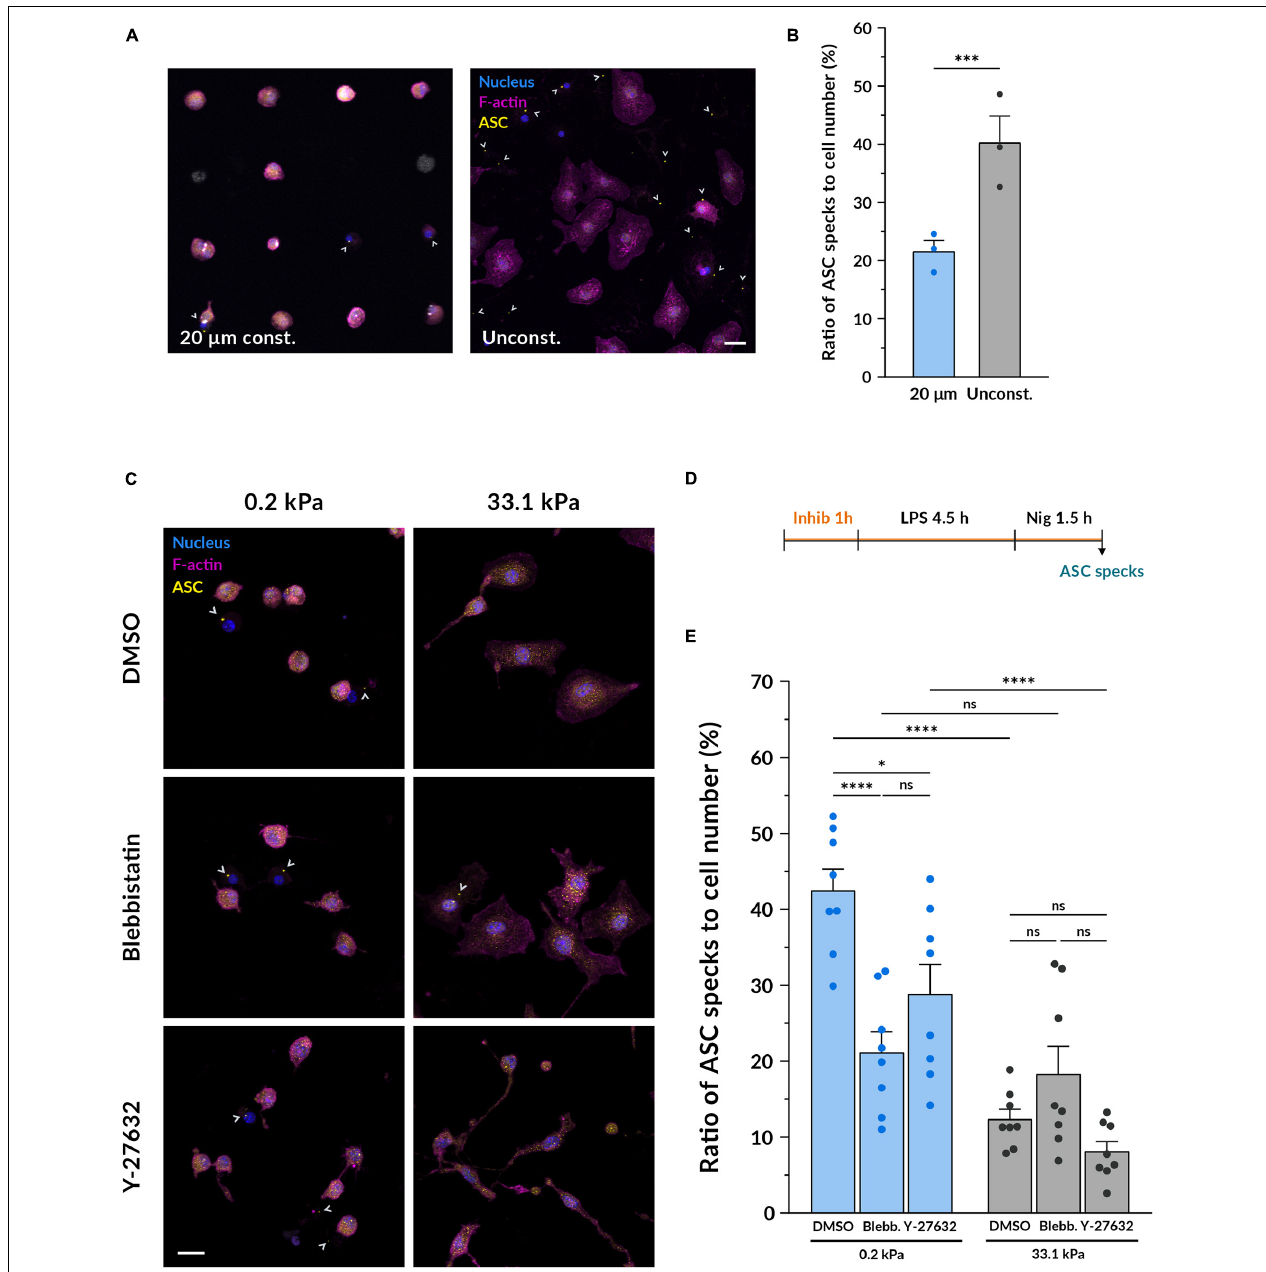
FIGURE 4 | Inhibiting myosin but not limiting cell spreading diminishes the differences induced by stiffness on inflammasome formation. (A) Representative confocal microscopy images of inflammasome formation under cell confinement. BMDMs were cultured on fibronectin-coated circular islands micropatterned on a glass substrate with a diameter of 20 µ m. Unconfined cells were grown on fibronectin-coated glass coverslips growing in an unconfined manner. After 14–18 h of culture, they were primed with 100 ng/ml LPS for 4.5 h and stimulated with 10 µ M nigericin for 1.5 h. Nuclei shown in blue, F-actin in magenta and ASC in yellow. Scale bar, 20 µ m. (B) Quantification of the ratio of ASC specks to cell number. Mean ± SEM are shown and each dot indicates an independent experiment done with BMDMs from different mice. The total number of cells analyzed was 1560 for the 20 µ m confined and 1524 for the unconfined adhesion area. Statistical analysis was performed using a 1D linear mixed model and p -values were determined by a likelihood ratio test. ∗∗∗∗ p < 0.0001. (C) Representative confocal microscopy images of inflammasome formation under actomyosin inhibition. BMDMs cultured on hydrogels for 14–18 h were pretreated with either 1:1700 DMSO as a control, 10 µ M blebbistatin or 10 µ M Y-27632 for 1 h. Keeping the respective inhibitor molecules, cells were then primed with 100 ng/ml LPS for 4.5 h and stimulated with 10 µ M nigericin for 1.5 h. Nuclei shown in blue, F-actin in magenta and ASC in yellow. Scale bar, 20 µ m. (D) Scheme of the experimental treatment applied in (C,E). (E) Quantification of the ratio of ASC specks to cell number. Mean ± SEM are shown and each dot indicates one of the different replicates obtained from three independent experiments. The total number of cells analyzed was, for compliant gels, 4673 (DMSO), 3528 (blebbistatin) and 5182 (Y-27632); and for stiff gels, 4859 (DMSO), 5447 (blebbistatin), and 5214 (Y-27632). Statistical analysis was performed using a one-way ANOVA followed by Bonferroni’s post hoc analysis to obtain the multiple comparison p -values. ns, not significant, * p < 0.05, *** p < 0.001, **** p < 0.0001.